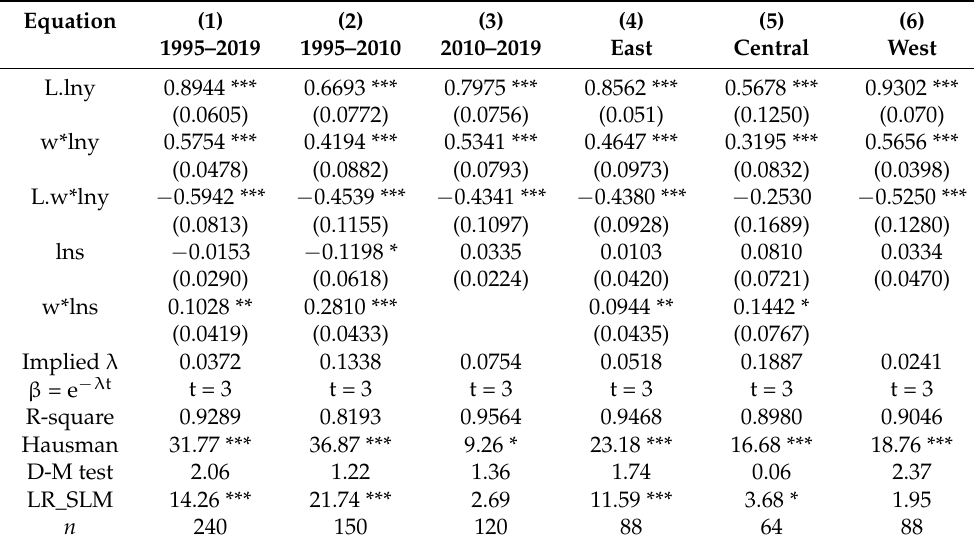
Table 6. Conditional Convergence Test of Spatial Dynamic Panel